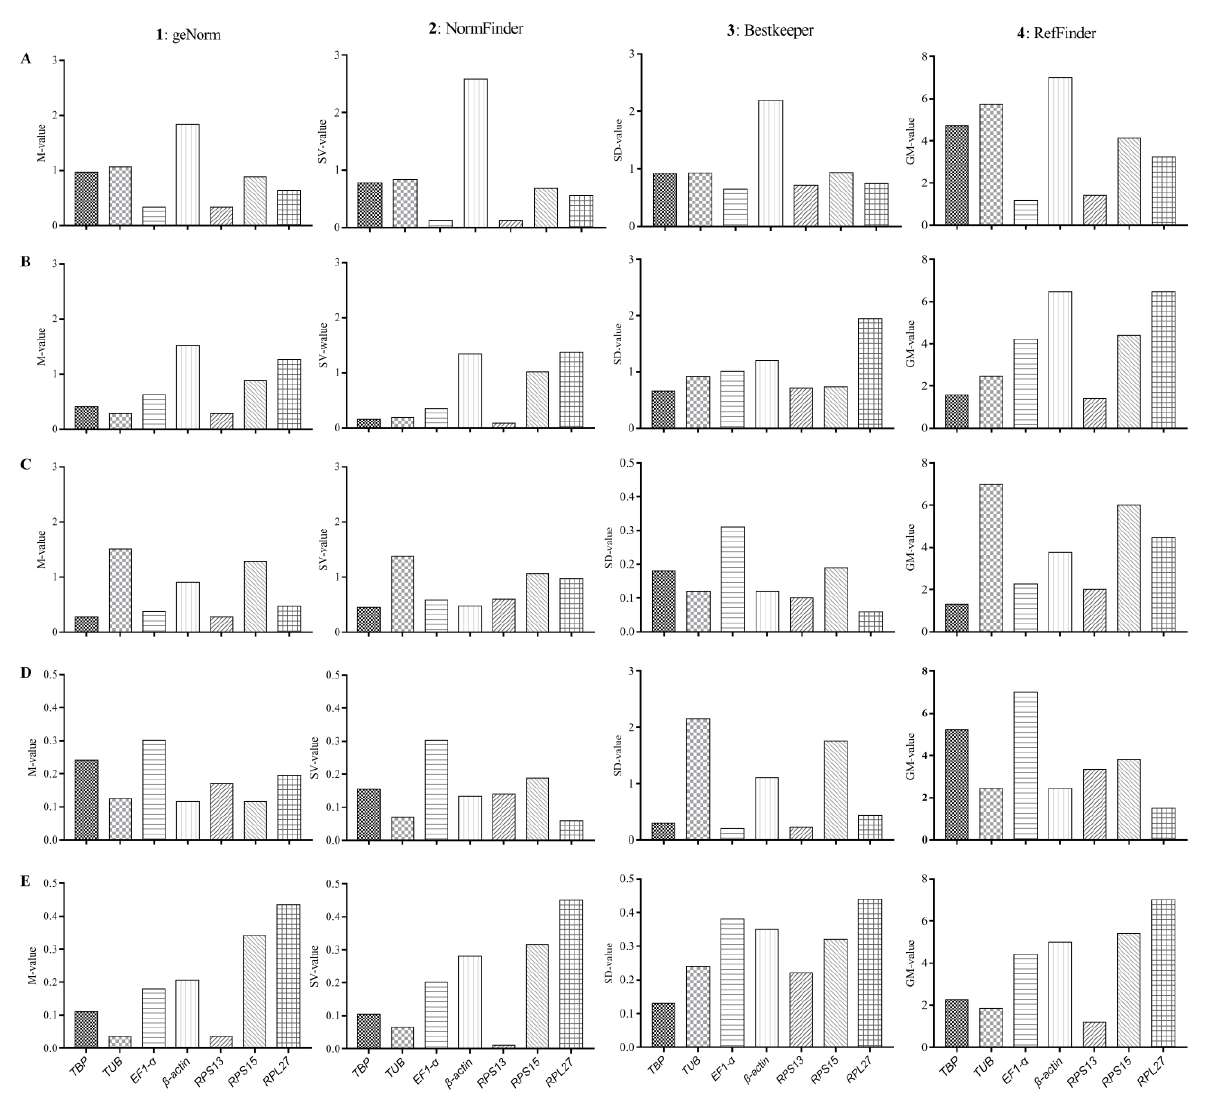
Figure 2. Stability analysis of the seven candidate reference genes expression of T. absoluta under the following experimental conditions: developmental stage ( A ), adult tissue ( B ), insecticide ( C ), temperature ( D ), and plant VOC ( E ), as calculated by four different software programs: geNorm ( 1 ), NormFinder ( 2 ), BestKeeper ( 3 ), and RefFinder ( 4 ).